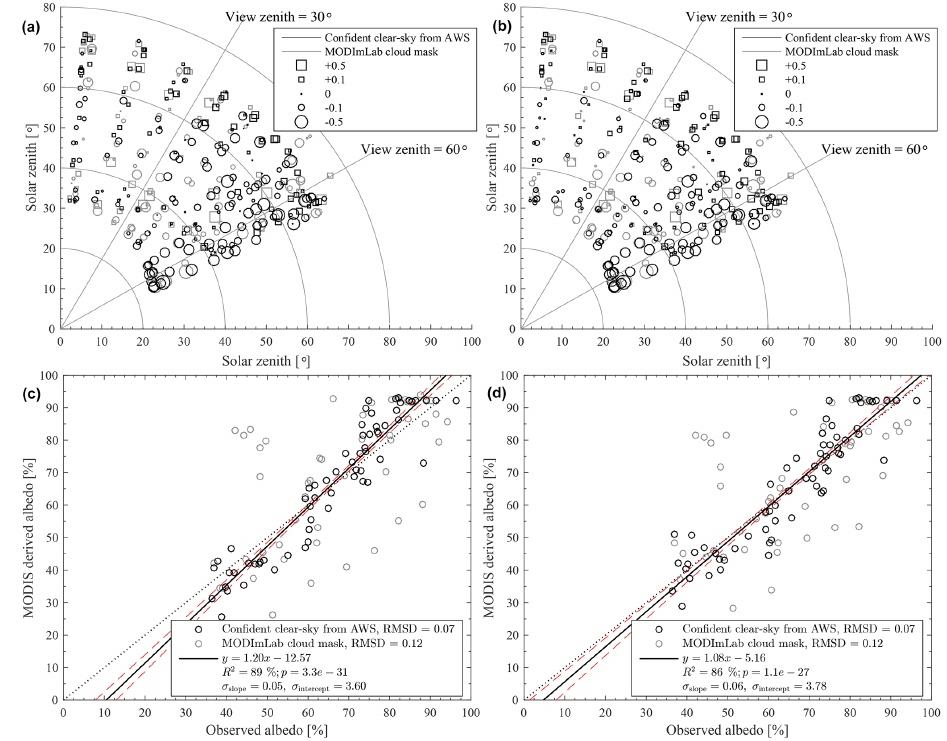
Figure 7. Agreement between MODIS-derived albedo ( α MOD ) and observed albedo ( α AWS ) using the isotropic (left) and anisotropic (right) reflectance model. Polar scatter plot of all clear-sky MODIS observations over the AWS measurement period showing the quality of the albedo retrieval as a function of solar and view zenith (top). The black symbols correspond to points with highly confident clear sky determined from the AWS record. Agreement between α MOD and α AWS for points with view zenith θ v <30 ◦ (bottom). The dotted line is the ideal 1 : 1 ratio. The dashed lines show the confidence interval for the linear regression (1 σ) . Table 1. Agreement between α MOD and α AWS under various scenarios, namely with and without the anisotropic reflectance model for snow and ice, using MODImLab cloud mask vs. confident clear-sky days determined from incoming shortwave from the AWS, and considering view zenith up to 30 and 45 ◦ respectively. Bold values indicate the best performing configuration for each